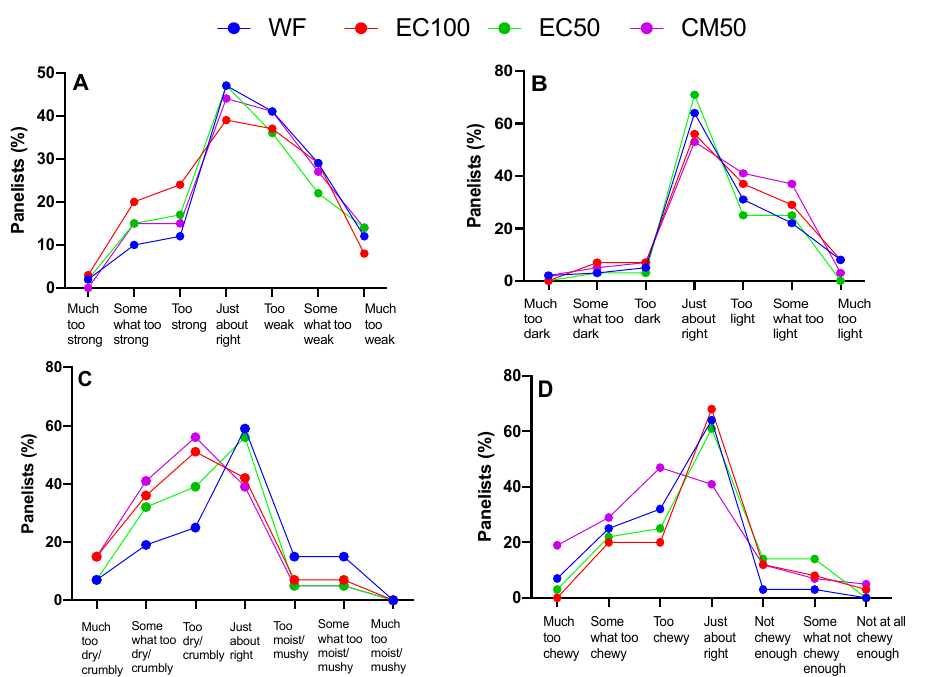
Figure 6. Just-about-right scales (% panelists) of whole wheat flour (WF) roti (Indian flat bread) samples fortified with encapsulated defatted Nannochloropsis oceanica (EC) and color-masked defatted Nannochloropsis oceanica (CM) at day 0 on ( A ) flavor, ( B ) color, ( C ) dry vs. moist and ( D ) chewiness; n = 58.